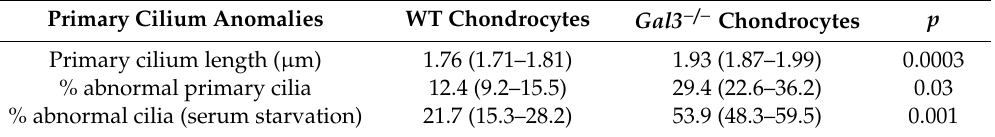
Table 2. Primary cilium anomalies in Gal3 − / −